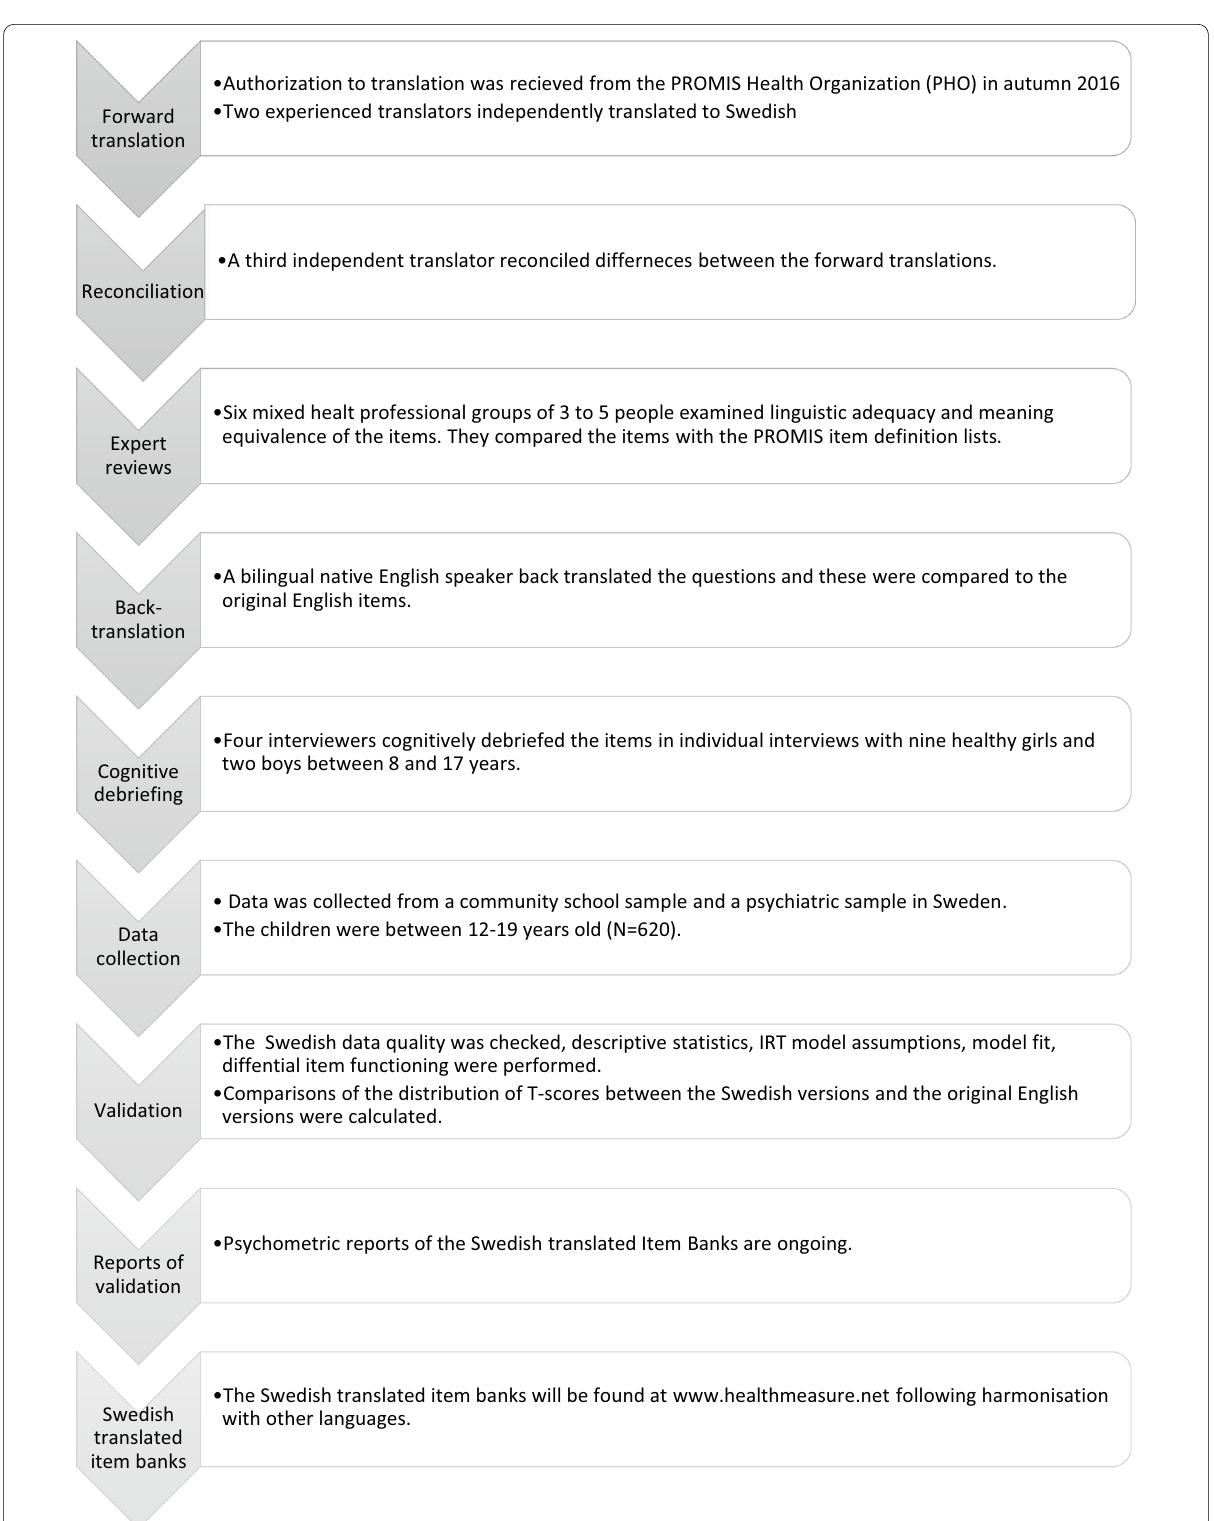
Fig. 1 The translation process from the PROMIS item banks to the Swedish translated item